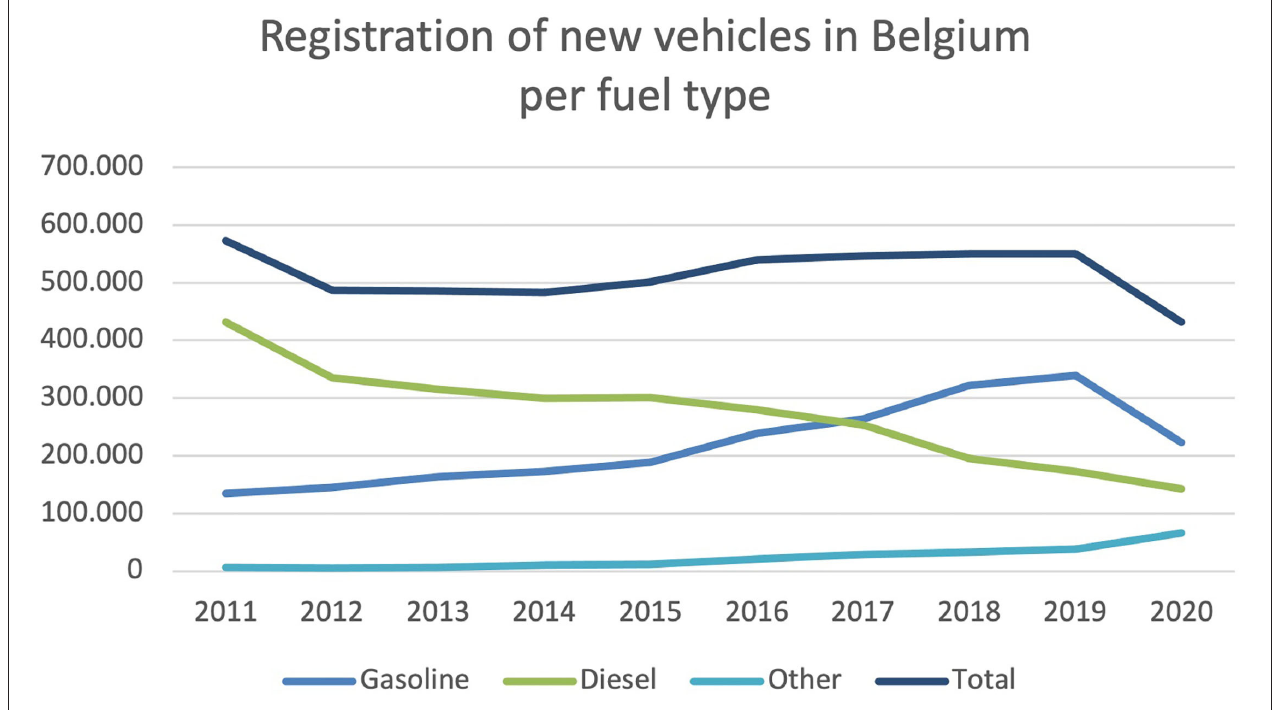
FIGURE 3 | Evolution of the sales of cars in Belgium per fuel type (data source: FEBIAC, 2021).